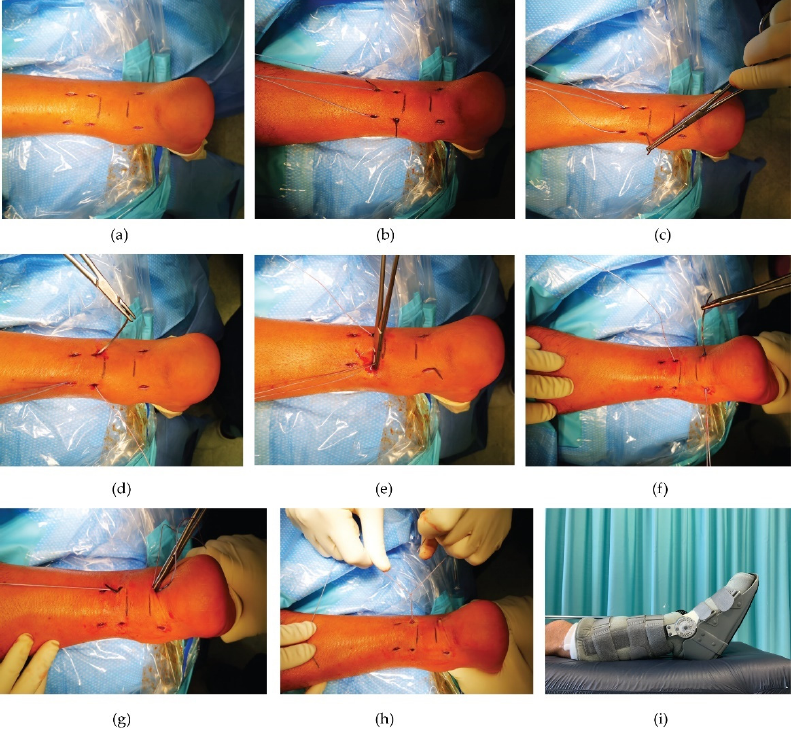
Figure 2. Ma and Griffith surgical technique. ( a ) During surgery, the site of the ruptured tendon is marked. ( b ) Six small incisions (5 mm) are performed at the sides of the proximal (4) and distal stump (2) of the tendon (2 cm apart from each other) to be able to direct and cross the wire suture ( c ) using nonabsorbable suture woven through the proximal and distal parts of the tendon. ( d – f ) The suture, with two semicurved needles at the ends, is transversely passed through the tendon followed by a (diagonal) cross-suture (at each end of the thread) in proximal to distal direction. ( g , h ) Maintaining the ankle in maximum equinus position, the suture is tied after arming the stumps and cutting the needles off, making the two segments of the tendon adhere. ( i ) Immediately after surgery, a brace in equinus position is applied.